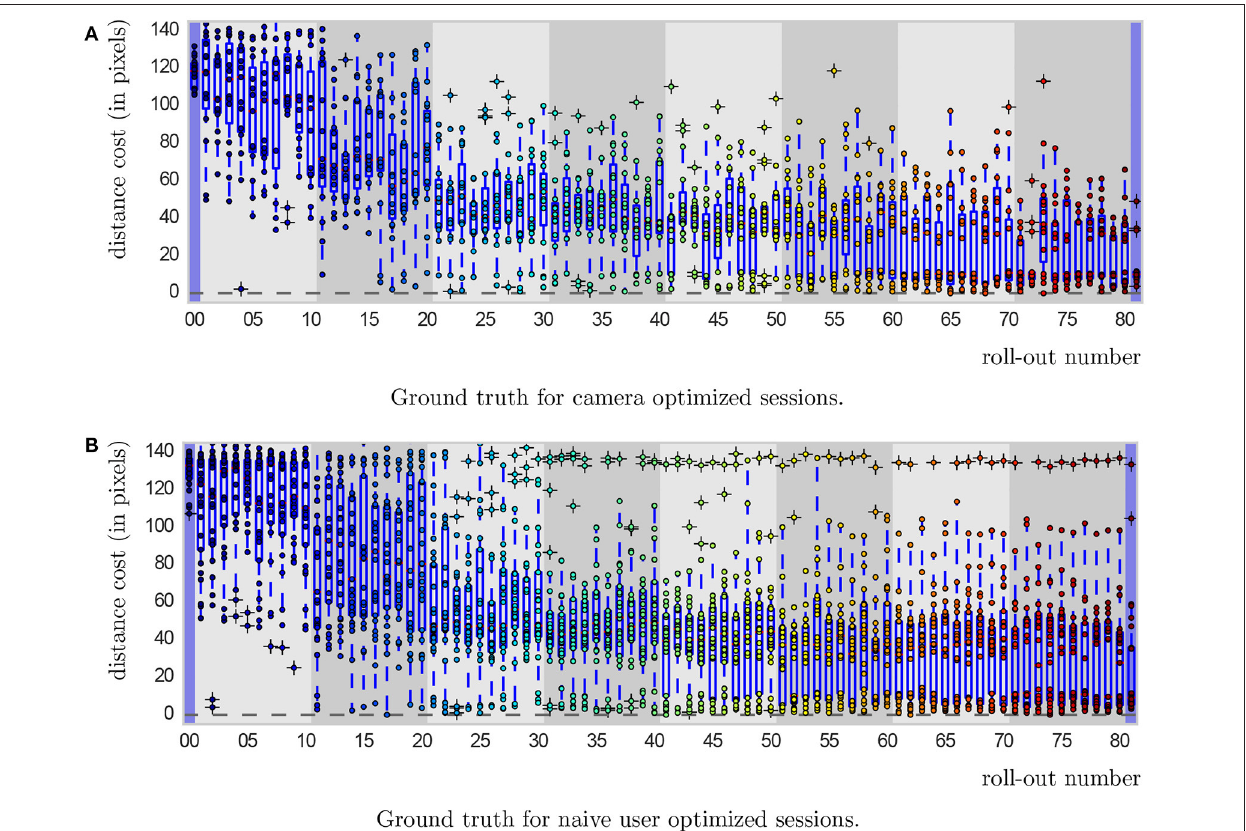
FIGURE 4 | Ground truth from cameras for the 80 roll-outs in a session. First and last movements (with blue background) are initialization and final mean, respectively. Gray backgrounds indicate batches (8 in total). The central mark of box plots is the median, the lower edge of a box is the 25th percentile and the upper edge the 75th percentile, the whiskers extend to 1.5 times the interquartile range. Dots with underlying crosses lye outside the whiskers and could be considered as outliers. Successful movement executions can clearly be distinguished from unsuccessful ones, as they lie in a “band” of distance costs between 0 and around 15, corresponding to the ball lying inside the cup. The ball passing directly next to the cup resulted in a computed cost larger than 20, resulting in the clear separation that can be